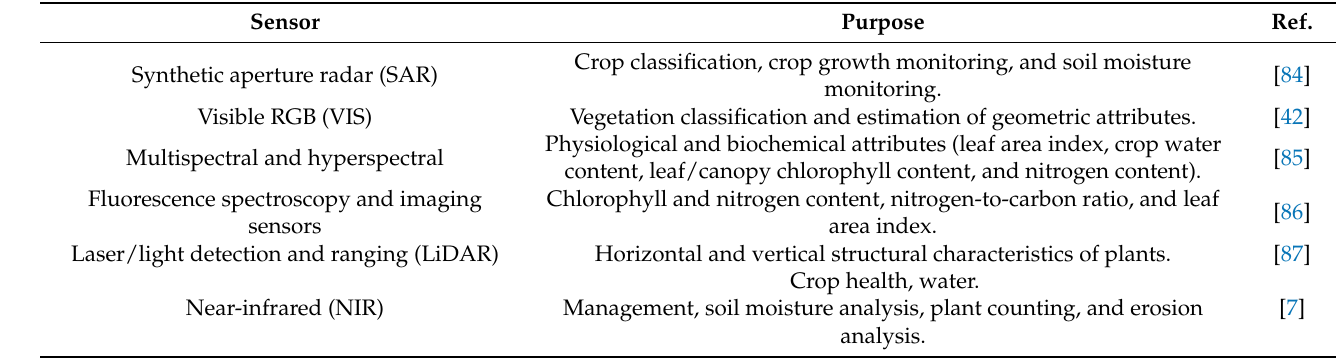
Table 1. Principal categories of remote sensing (RS) sensors with their respective functions in agricultural studies.